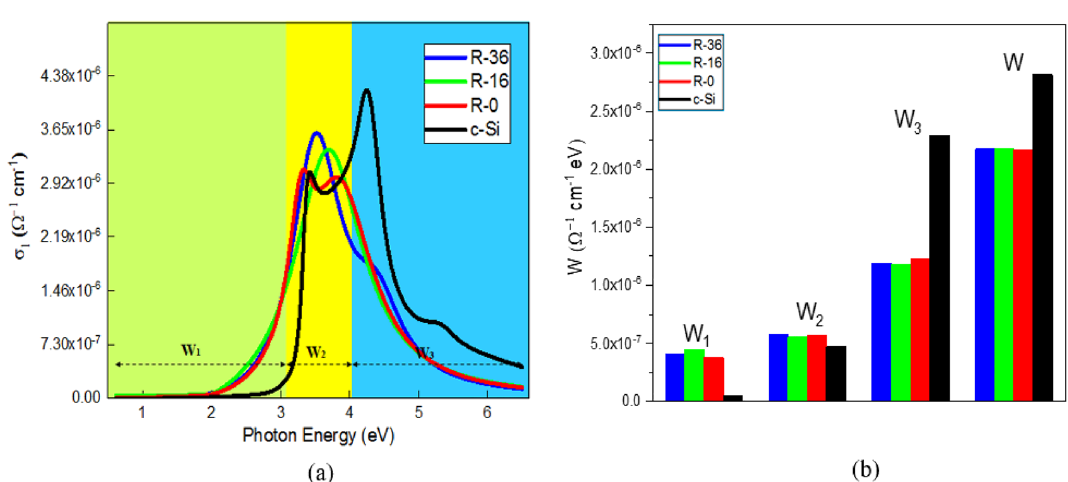
Figure 6. ( a ) Optical conductivity ( σ 1 ) spectra, and ( b ) spectral weight of R-0, R-16, R-36 and c-Si. Inset: The estimated spectral weight transfer over three energy ranges: 0.6–3.1 eV ( W 1 ), 3.1–4.0 eV ( W 2 ), and 4.0–6.5 eV ( W 3 ), while W is defined as W 1 + W 2 + W 3